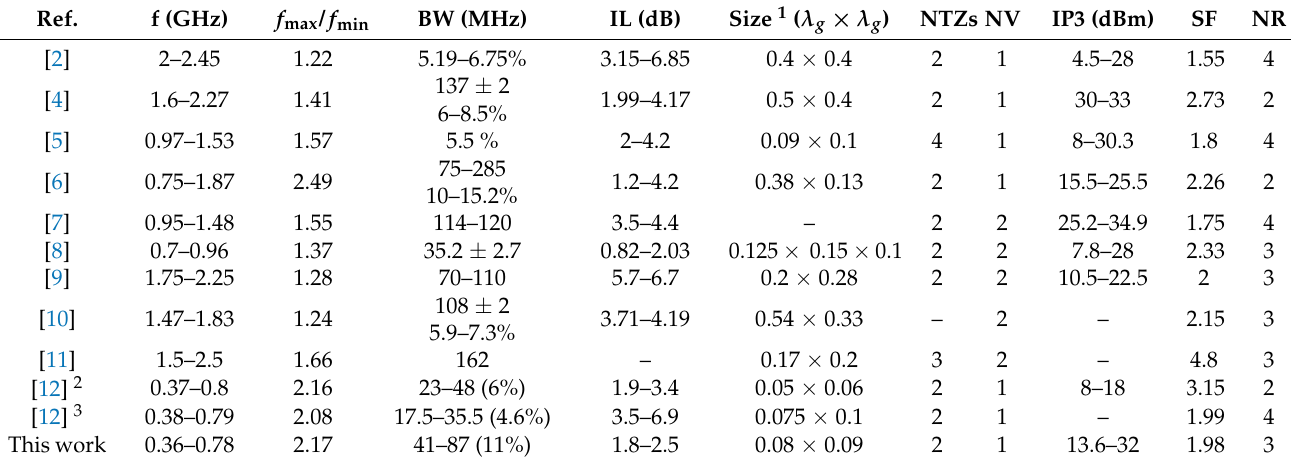
Table 3. Comparison between the proposed and the reference